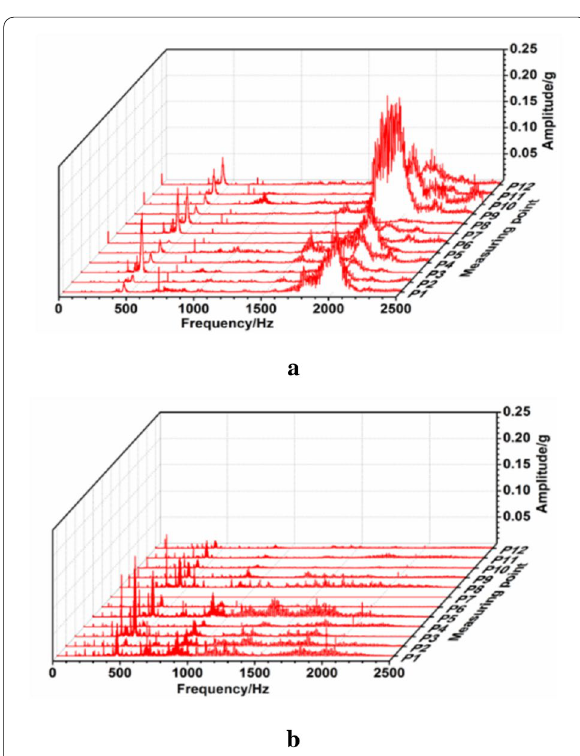
Figure 8 Gearbox vibration signal waterfall map (70 r/min): a before optimization, b after optimization